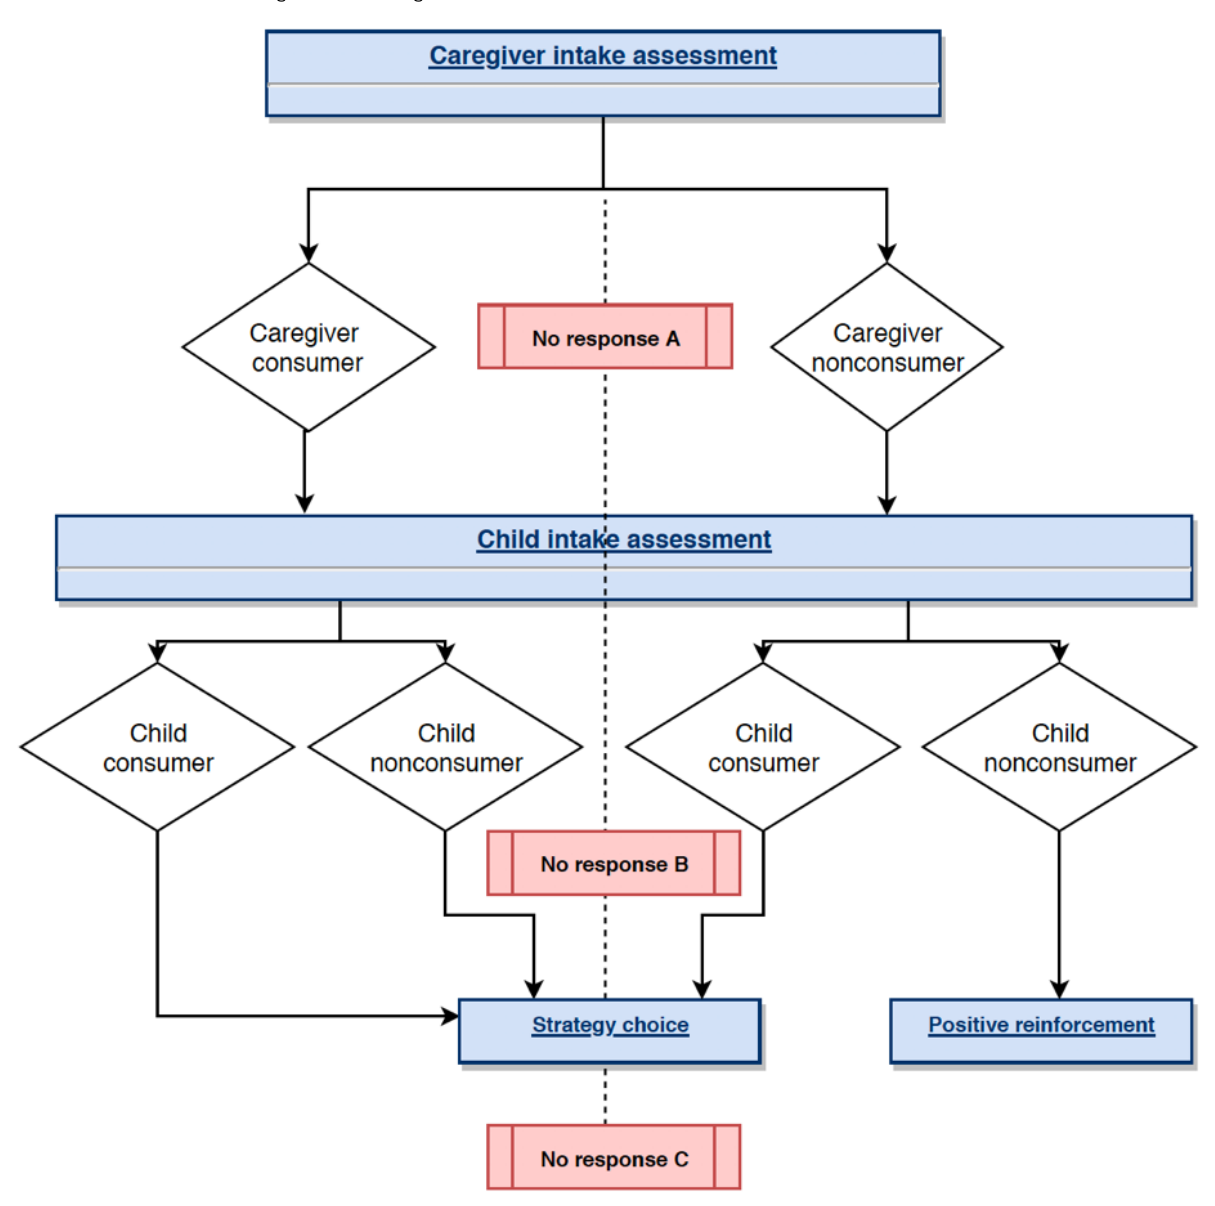
Figure 2. Decision tree for the caregiver text message–based